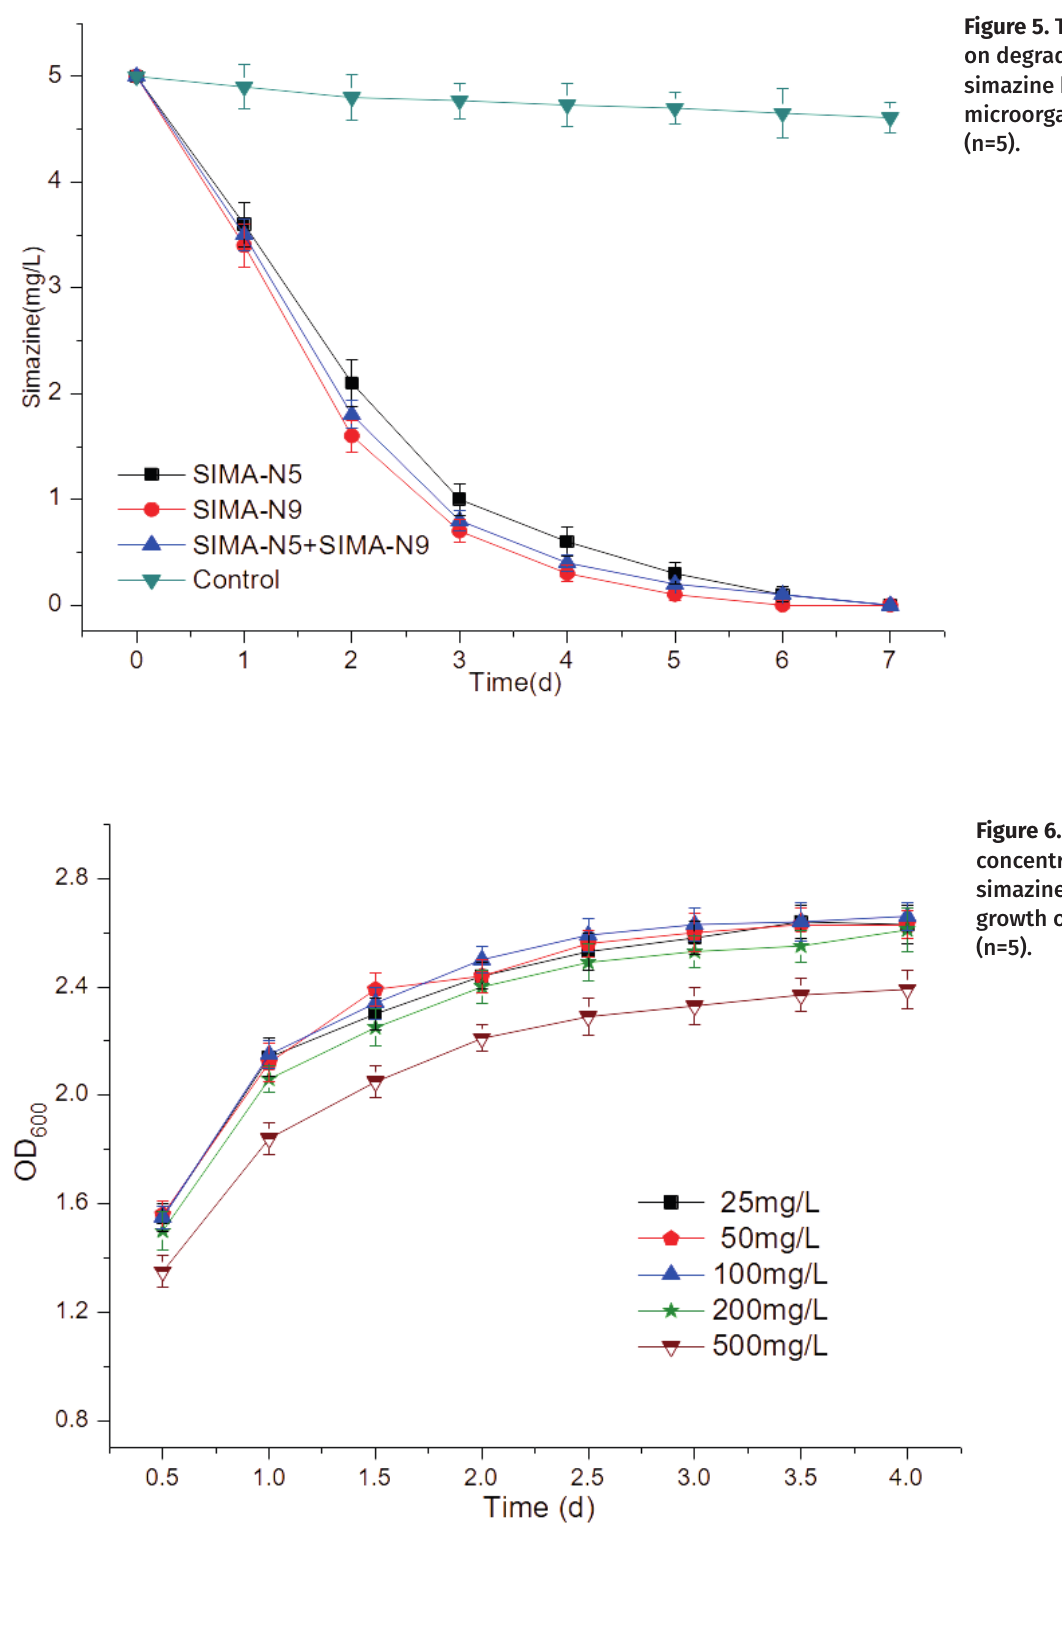
Figure 5 . The curve on degradation of simazine by different microorganisms (n=5).